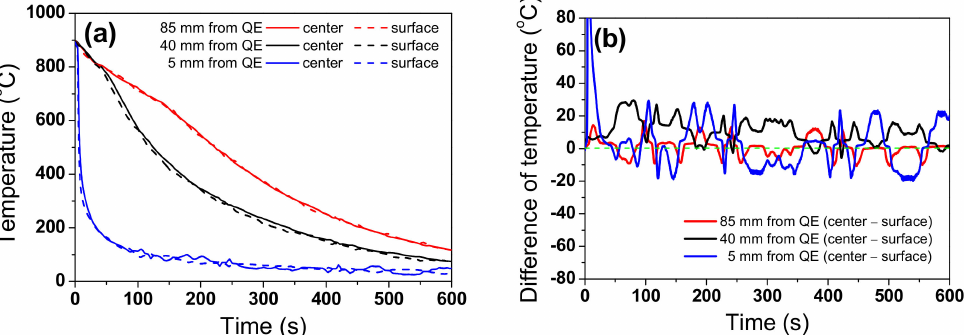
Figure 3. Comparison of ( a ) temperature profiles and ( b ) temperature difference between the center and surface area of the standard Jominy specimen with cooling time and